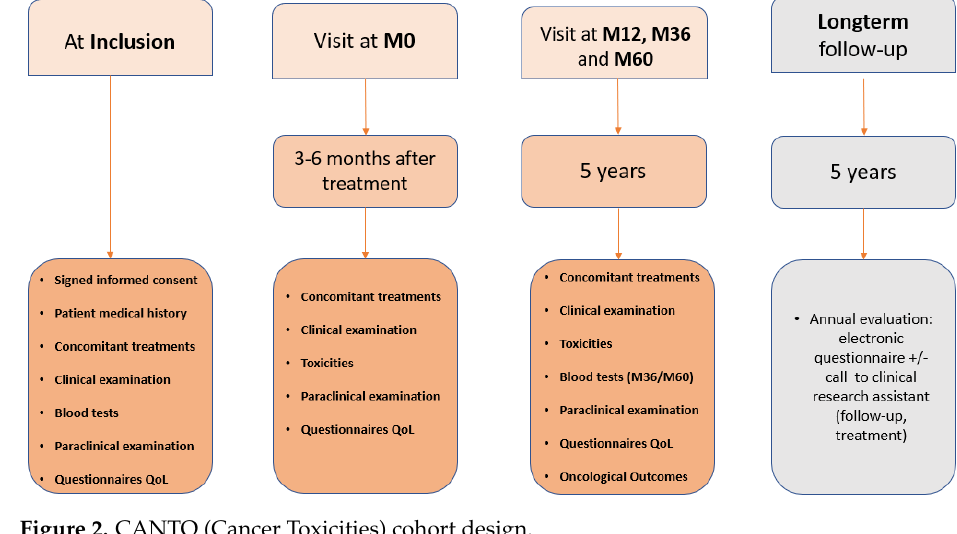
Figure 2. CANTO (Cancer Toxicities) cohort design.